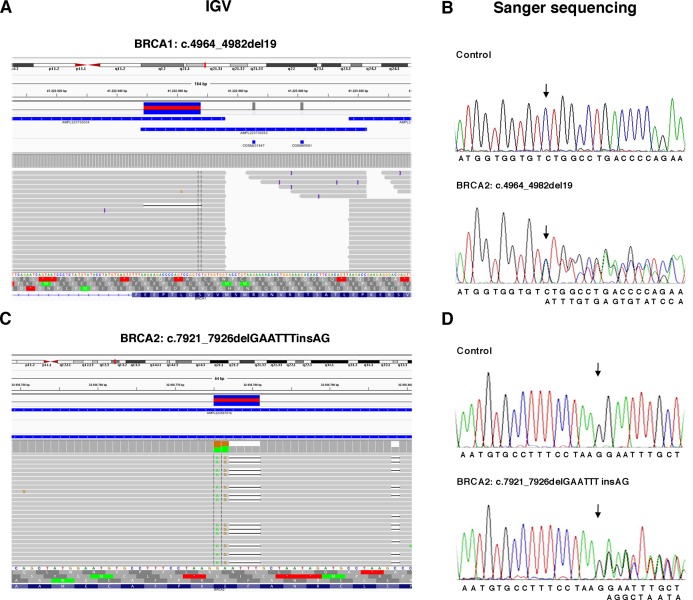
Representative image of read alignments showing the germline mutations of BRCA1 and BRCA2 detected by NGS analysis after minimal adjustments in the analytical pipeline of Torrent Suite Software.Read alignments visualized with IGV showing the germline mutation of BRCA1, c.4964_4982del19 (p.Ser1655Tyrfs) and BRCA2, c.7921_7926delGAATTTinsAG (p.Glu2641Argfs) (A and C). On the right side of the image, representative validation of NGS data by Sanger sequencing. Germline mutations were detected in the patients but not in the control subject. Arrows indicate the position of the mutated nucleotides (B and D).